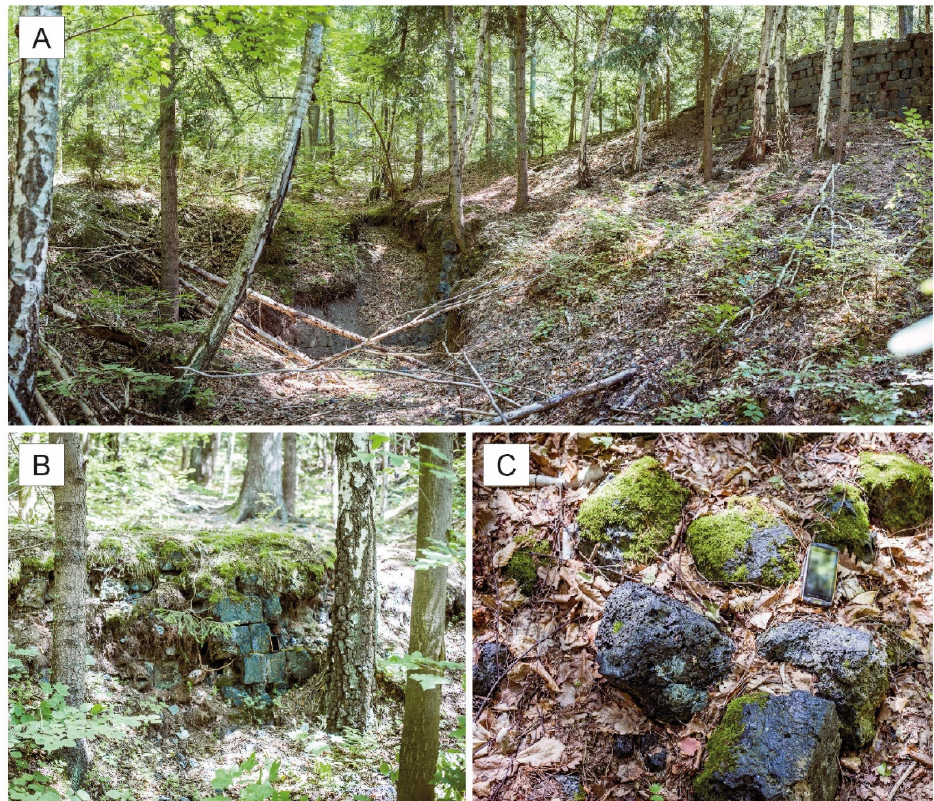
Figure 2. Photographs presenting slags in Sites 1A and 1B surrounding. ( A ) Historical entrance to the mine shaft and slag wall (on the top-right part of the photo); ( B ) slags used as building support near the historical shafts; ( C ) big slag blocks at the 1B site.